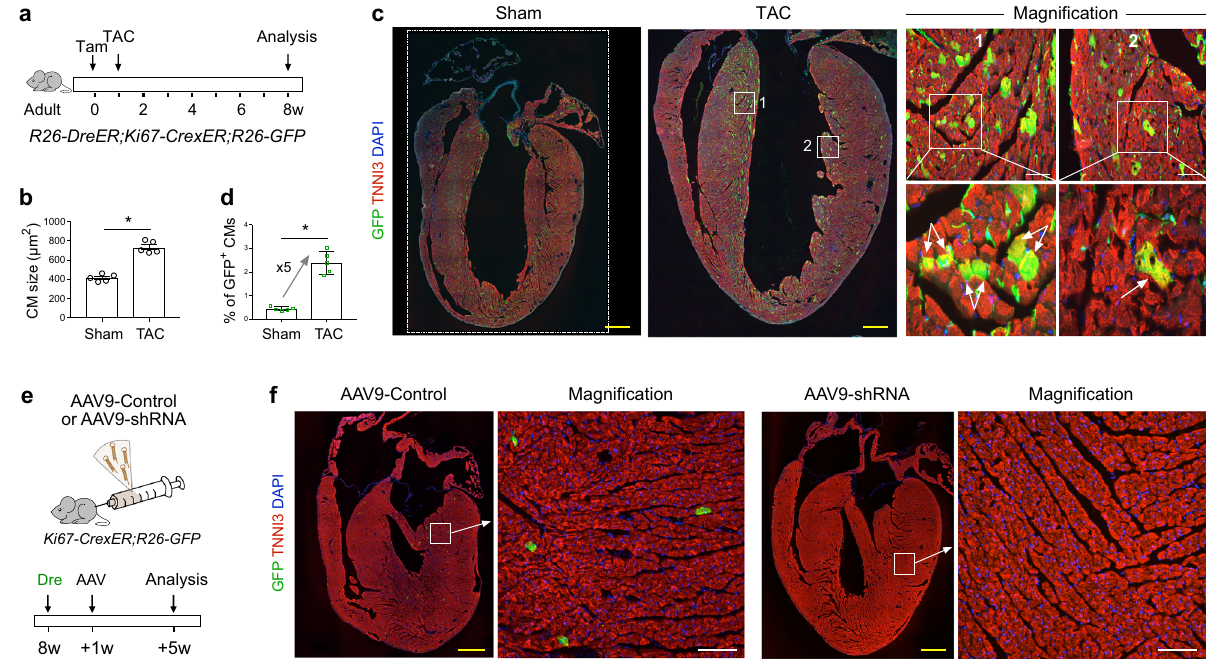
Fig. 8 Pressure overload and Hippo pathway in fl uence cardiomyocyte cell-cycle activity in the adult heart. a Schematic showing experimental design. b Quanti fi cation of cardiomyocyte (CM) size in sham or TAC hearts. Data are mean ± s.e.m.; n = 5; * P < 0.0001 when using two-tailed unpaired t -test. c Immunostaining for GFP and TNNI3 on heart sections from R26-DreER ; Ki67-CrexER ; R26-GFP mouse after Sham or TAC. Boxed regions c1 and c2 are magni fi ed on the right panel. Arrows, GFP + cardiomyoyctes. d Quanti fi cation of the percentage of cardiomyocyte expressing GFP. Data are mean ± s.e.m.; n = 5; * P < 0.0001 when using two-tailed unpaired t -test. e Schematic showing experimental design. f Immunostaining for GFP and TNNI3 on heart sections. Scale bars: yellow 1 mm; white 100 µ m. Each image is representative of 5 individual biological